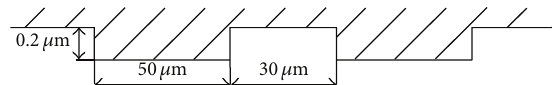
Figure 8: Schematic representation of the deterministically struc- tured surface.